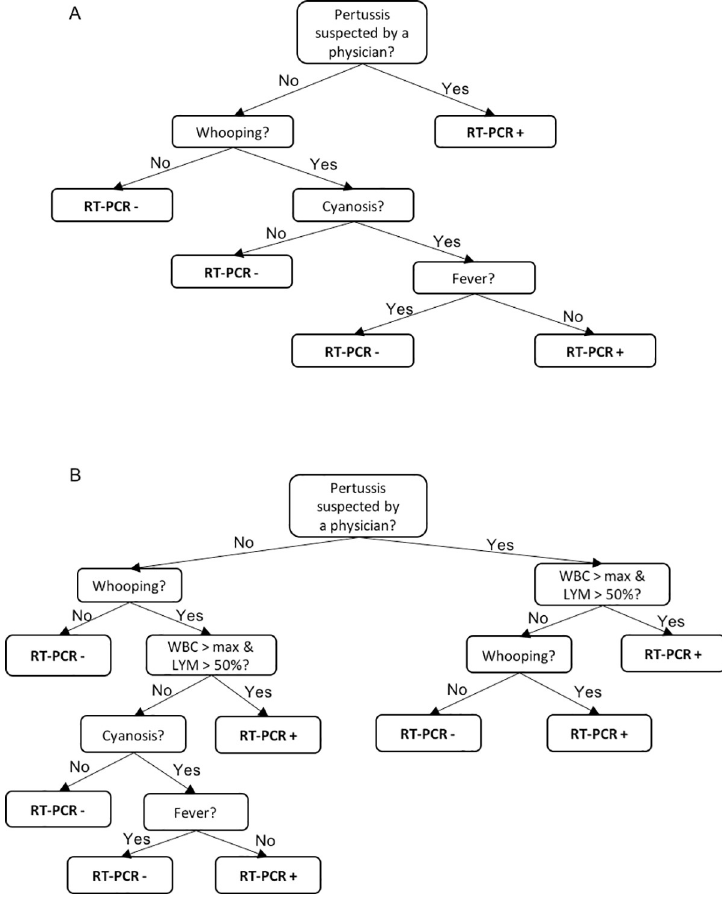
Fig 1. Clinical algorithm for predicting a case with RT-PCR+ for pertussis. (A) Clinical algorithm developed with clinical symptoms only. (B) Clinical algorithm developed with the addition of white blood cell count.